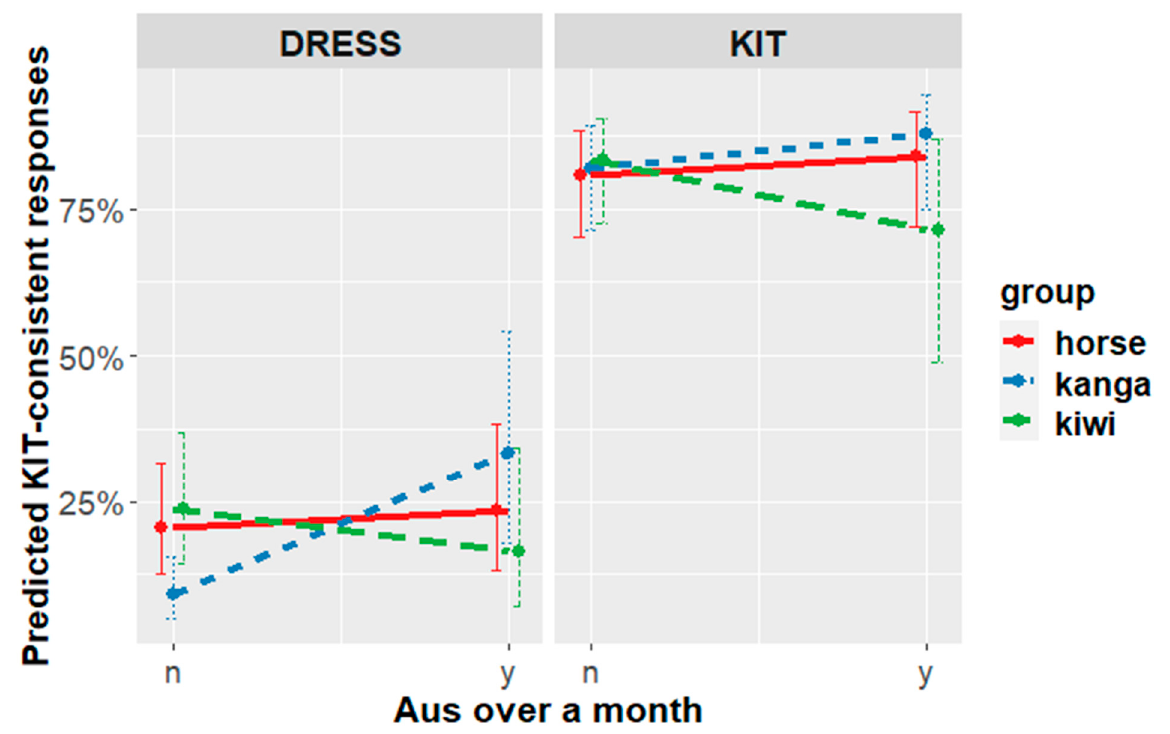
Figure 8. Experiment two model prediction plot from model fit to women only (model details in Supplementary Materials). The figure shows a three-way interaction involving time spent in Australia (binary—on x-axis), prime-type (lines), and frame (panels).